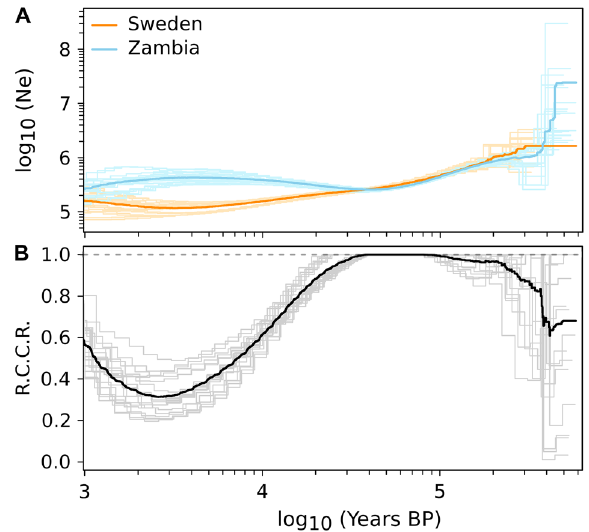
Figure 3. ( A ) Population sizes estimated by MSMC2 for the Swedish (blue) and Zambian (orange) samples. Population sizes were obtained by rescaling coalescence rates using the empirical mutation rate of Huang et al. (2016), 5.21 × 10 –9 . The x-axis represents time in years assuming a generation time of 15 generations per year (Pool 2015). In the more distant past, both curves display identical sizes suggesting a common ancestral population. ( B ) RCCR: Relative cross-coalescence rates between the Swedish and Zambian samples. RCCR = 0 indicates full-isolation between both populations and RCCR = 1 indicates a panmictic